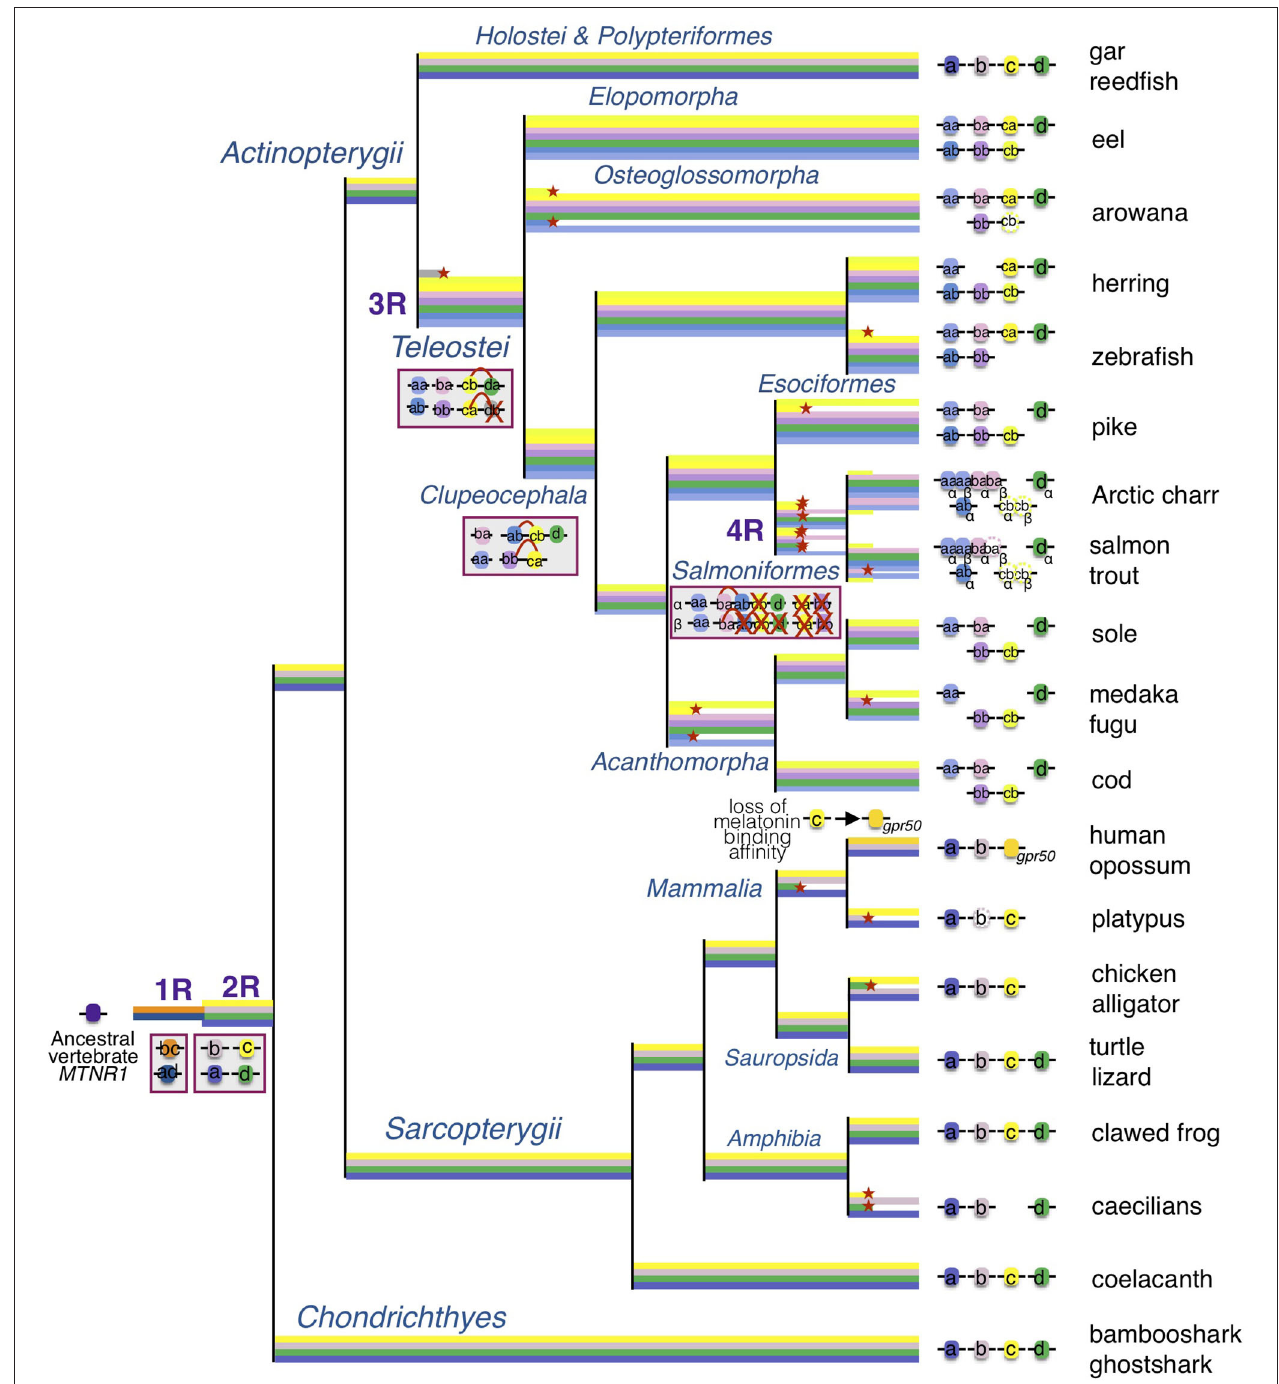
FIGURE 9 | Evolutionary scenario of the melatonin receptors in vertebrates. This evolutionary scenario was developed on the basis of the phylogeny and synteny analyses ( Figures 2 – 4 and Supplementary Figures 2 – 5 ). The four receptor genes are derived from duplication of an ancient mtnr1 gene through vertebrate tetraploidization (1R and 2R). The teleost 3R event generated duplicates of the four mtnr subtypes. Multiple and selective gene losses occurred, leading to mtnr gene repertoires differing between the main gnathostome lineages. Genome tetraploidization events (1R, 2R, 3R, and 4R) are indicated in purple. Major gene gain and loss events as well as chromosome rearrangements are indicated in red boxes. Genes located on the same linkage group are represented by clusters on the genomic DNA line. Red crosses indicate gene loss. The red arc indicates genomic region fusion events. Colored tree branches represent mtnr gene lineages. Red star * on a tree branch indicates gene loss. The receptor identities are indicated in or beside the boxes. Paralogs originating from teleost 3R are designated by a and b suffixes, and salmonid 4R paralogs are designated by α and β suffixes.